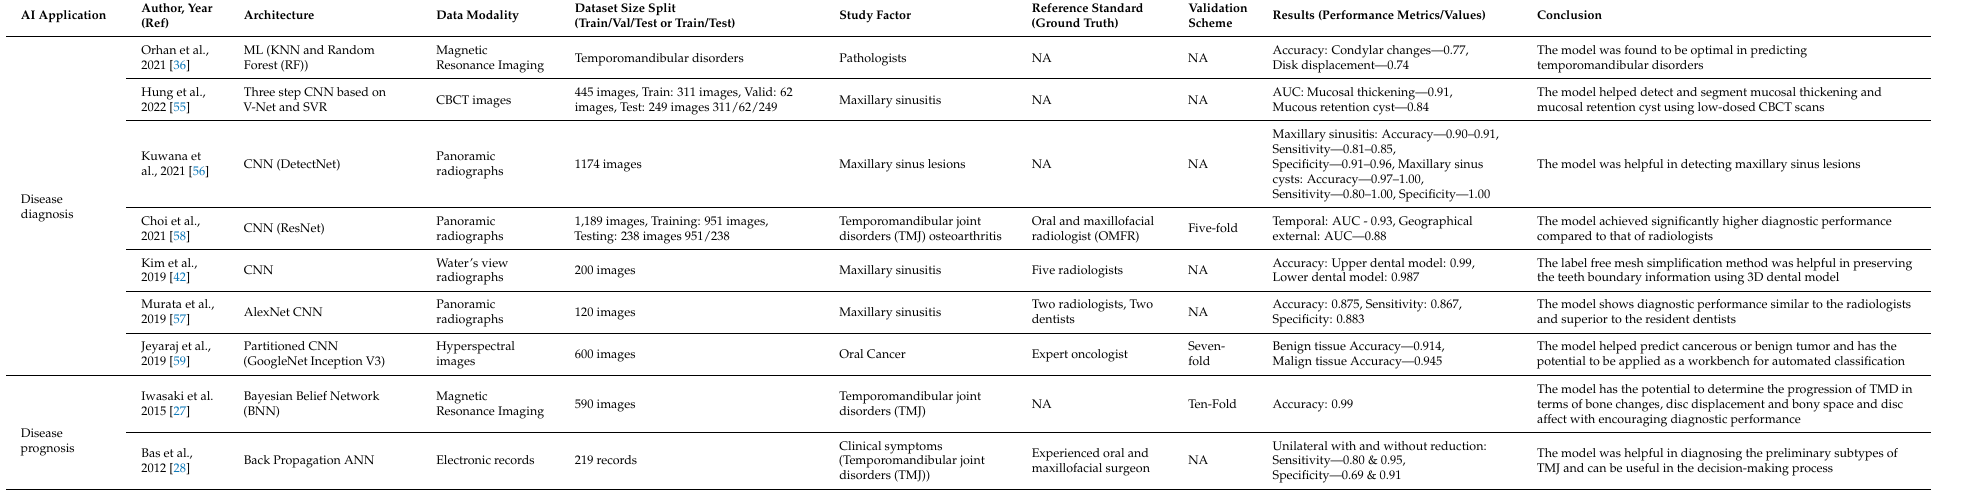
Table 7. Summary of related studies for AI application in oral